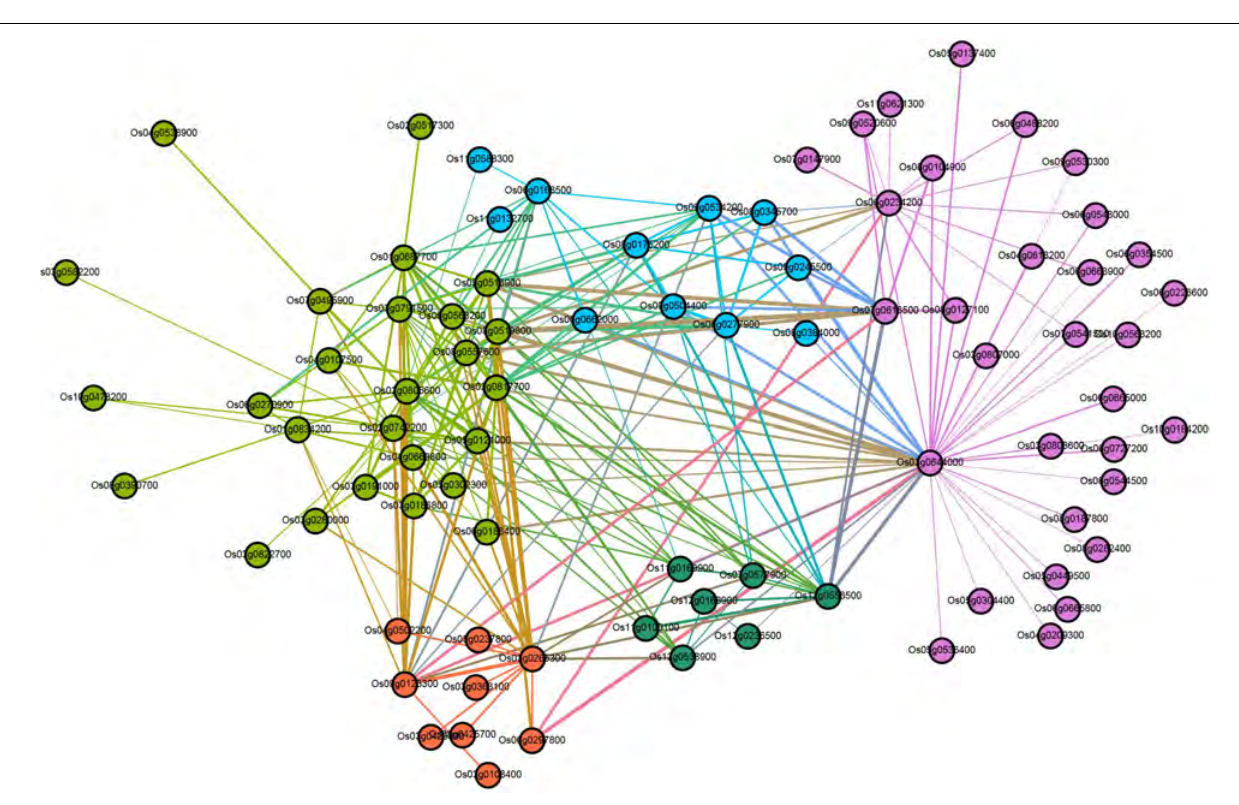
FIGURE 6 | Co-expression regulatory network analysis of turquoise